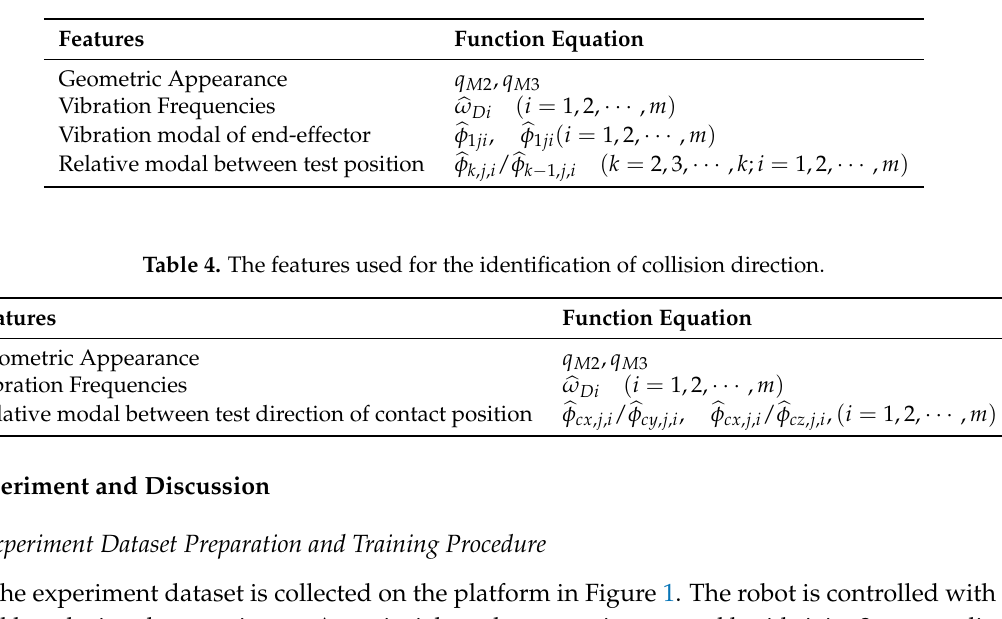
Table 3. The features used for the isolation of contact position.